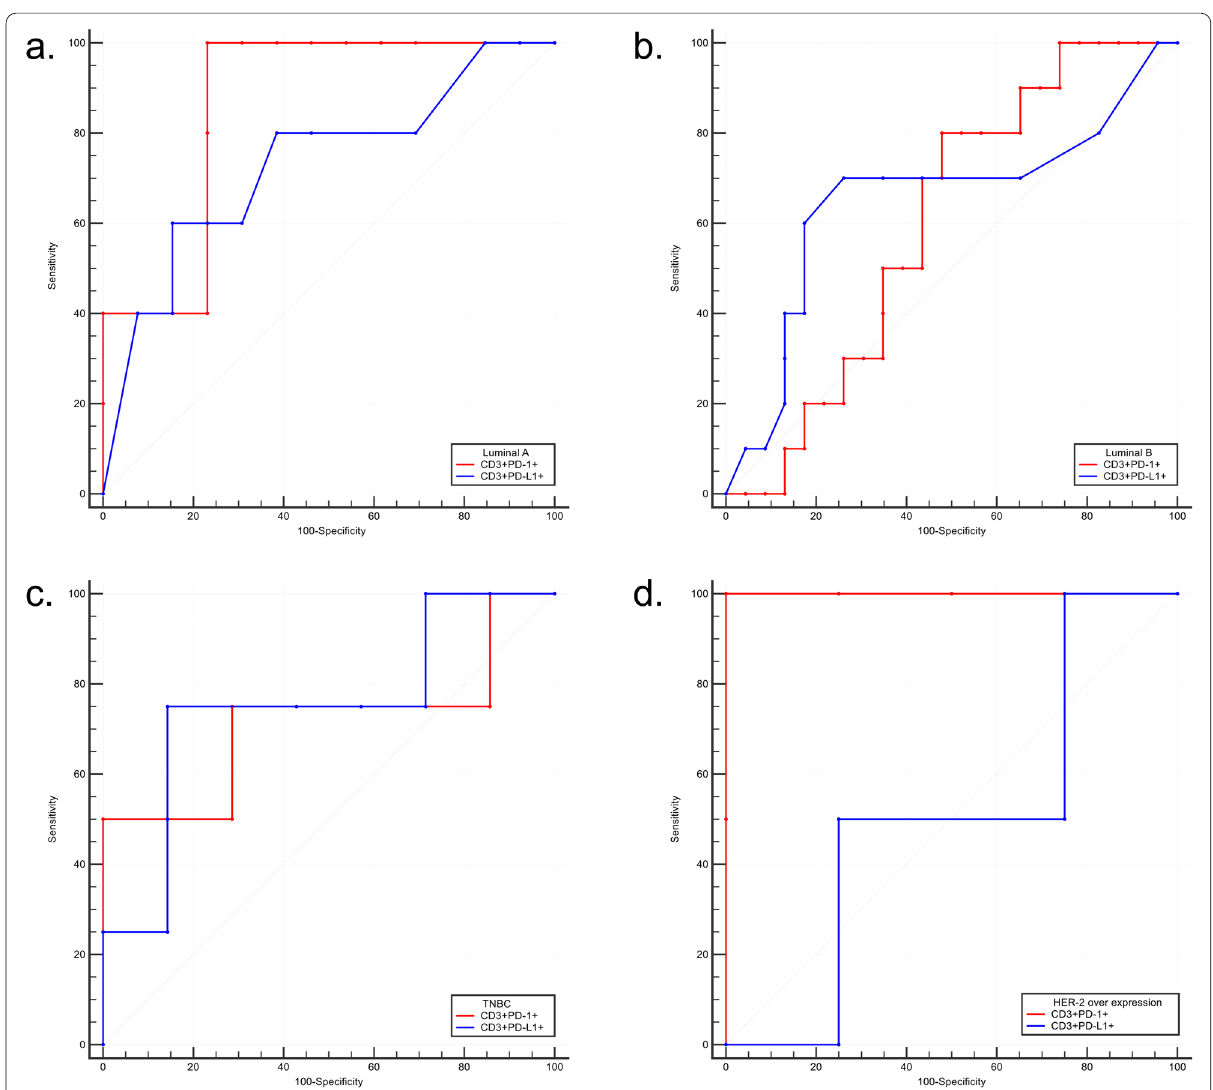
Fig. 4 ROC curve of peripheral PD-1/PD-L1 expression and TME PD-L1 expression in molecular subtypes. A Luminal A, B Luminal B, C TNBC, D HER-2